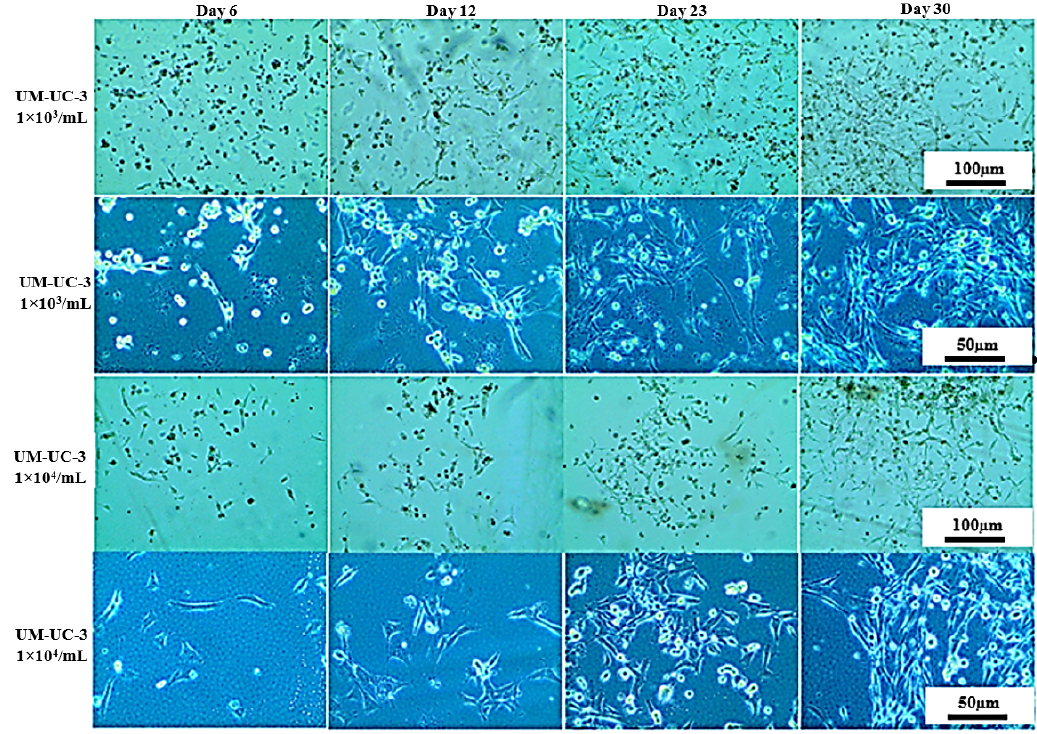
Figure 10. Representative images showing UM-UC-3 cells morphology seeded on LOC platform and cultured in the incubator 37 °C, 5% CO 2 (standard growth conditions) .